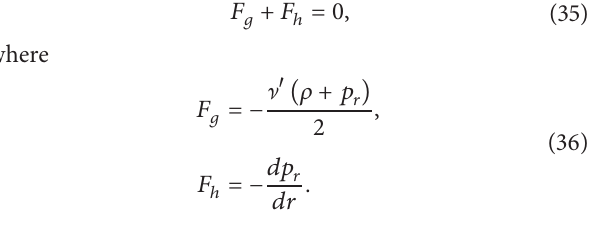
Equation (34) demonstrates the equilibrium of the